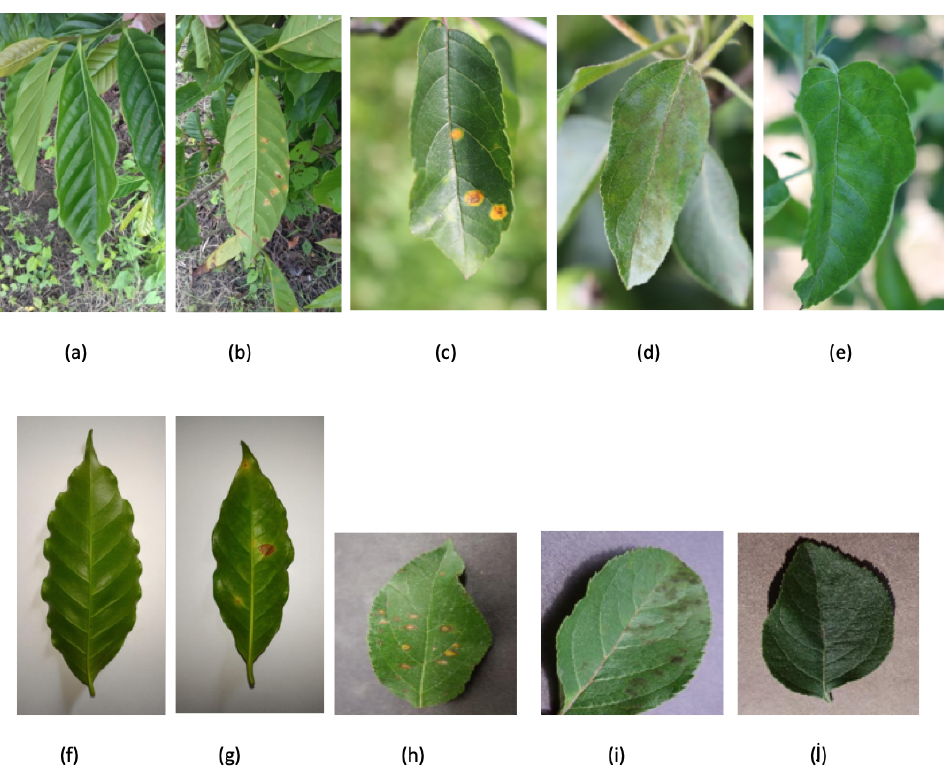
Figure 1. Examples of leaves from the dataset employed. In the first line are reported the leaves collected in field, where ( a , b ) belong to ROCOLE dataset, and ( c – e ) belong to Plant Pathology dataset. From left to the right: ( a ) healthy coffee leaf; ( b ) rust coffee leaf; ( c ) cedar rust apple leaf; ( d ) scab apple leaf; ( e ) healthy apple leaf. In the second lines are reported the related leaves collected in a controlled environment, where ( f , g ) belong to BRACOL dataset, and ( h – j ) belong to Plant Village dataset. From left to the right: ( f ) healthy coffee leaf; ( g ) rust coffee leaf; ( h ) cedar rust leaf; ( i ) scab leaf; ( j ) healthy leaf.